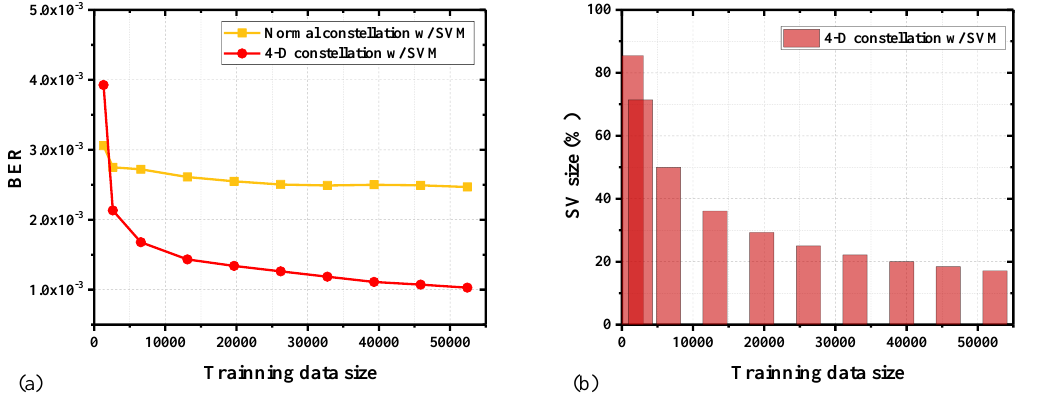
Figure 4. ( a ) BER versus training data size. ( b ) The percentage of SV size versus training data size for 4-D constellation with SVM.